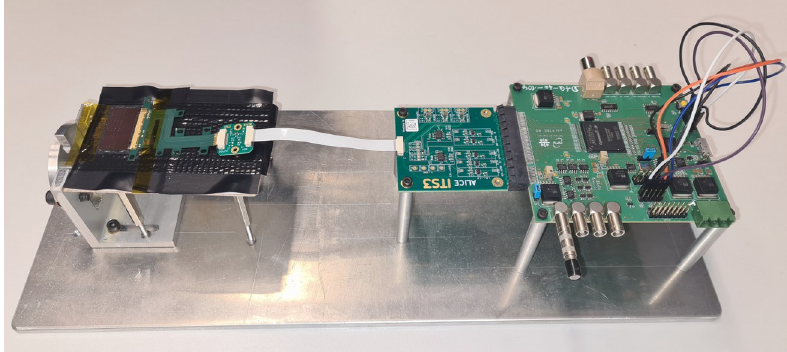
Fig. 1. Setup assembled for the electrical tests with flat ALPIDE.